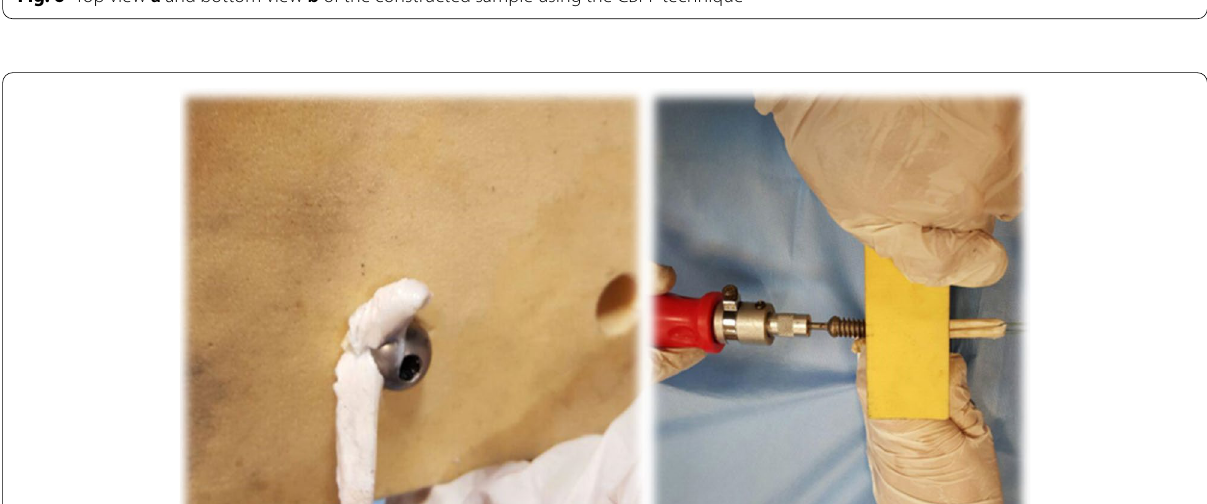
Fig. 7 Placing the screw in the fixation tunnel and the sample of fixed graft in the tunnel by interference screw using Sawbones blocks with a density of 320 kg/m